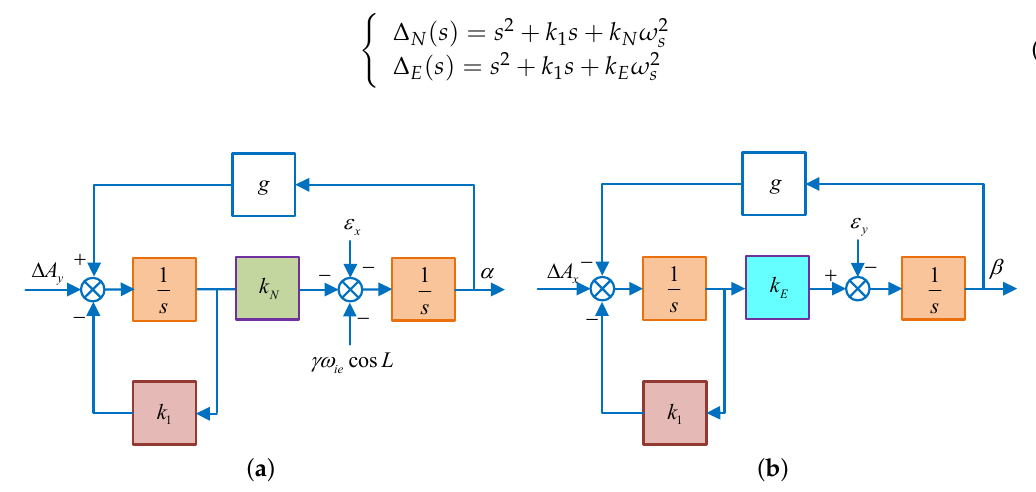
Figure 2. The schematic diagram of horizontal fine alignment. ( a ) Schematic diagram of horizontal fine alignment in the north loop; ( b ) schematic diagram of horizontal fine alignment in the east loop.